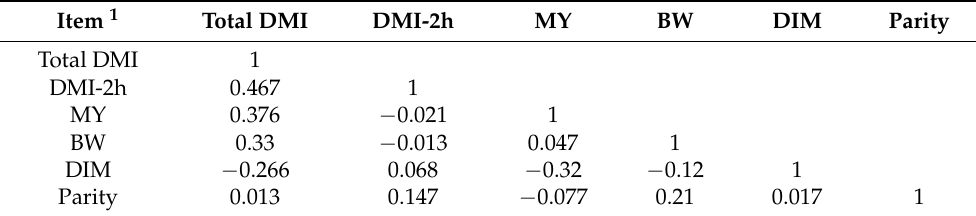
Table 2. Pearson correlation coefficient of each independent variable to total dry matter intake.